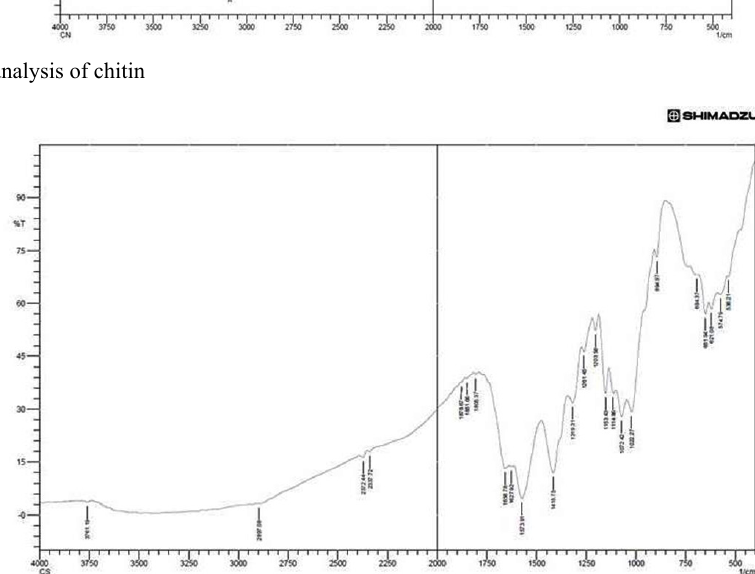
Fig. 8. FTIR analysisof